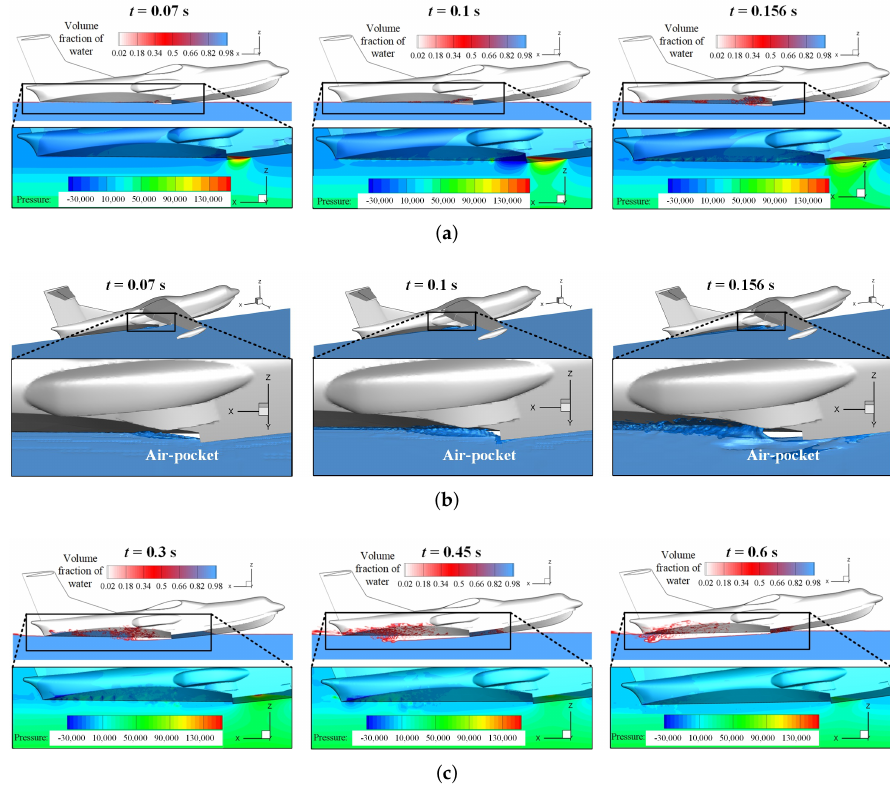
Figure 11. Time-snapshots of flowfield of aircraft landing in calm water: ( a ) air-water phase contour and pressure distribution during the impacting stage; ( b ) 3D view of free-surface evolution during the fuselage impacting stage; ( c ) air-water phase contour and pressure distribution during the pitch-up